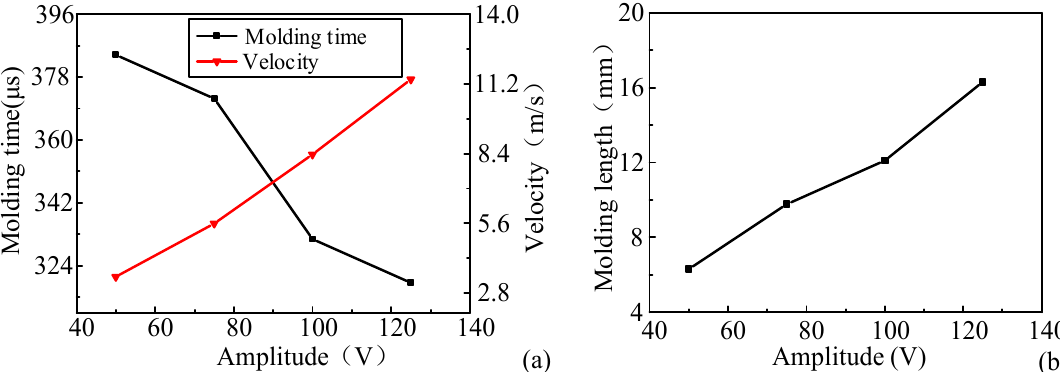
Figure 9. ( a ) The changing curves of molding time and velocity; ( b ) the relationship curve of molding length and amplitude.